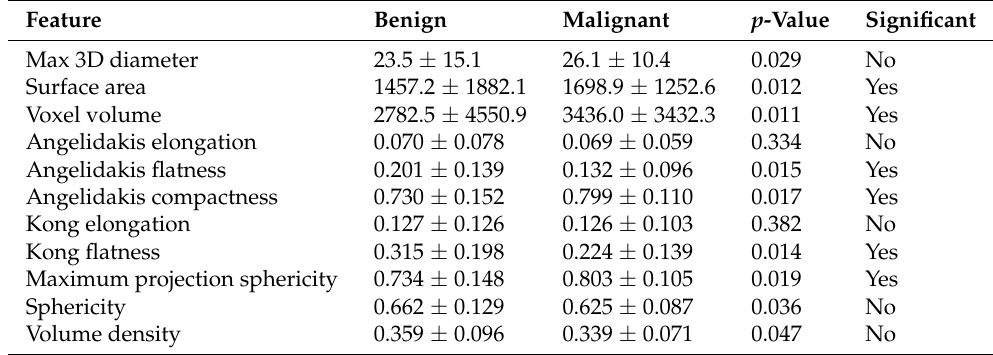
Table 5. Results of the univariate analysis on the LUNGx dataset. Units of measure: maximum 3D diameter [mm], surface area [mm 2 ], and volume [mm 3 ]; all other features are in dimensionless units (range 0–1).